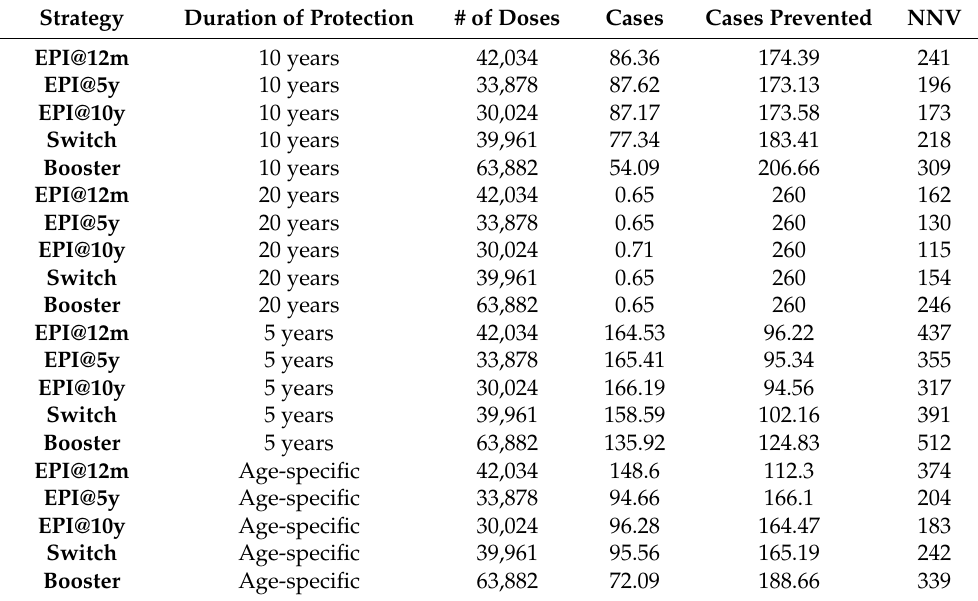
Figure 3. Box plot showing the median, interquartile range, and full range of the predicted total number of cases for different immunisation strategies in the time period 2010–2060 from 200 simulation runs. Table 2. Number of doses given, number of cases predicted and averted, and number of doses needed to prevent one case for each immunization strategy for the time period 2011–2060. All of the numbers, apart from the number of people needed to vaccinate (NNV), are in the thousands. Averages across 200 simulation